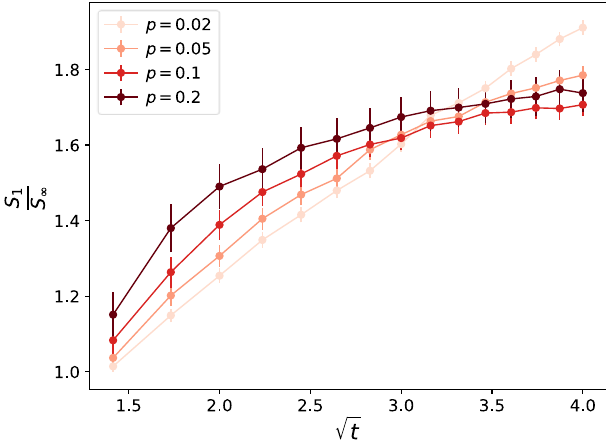
FIG. 10. Entanglement dynamics in the statistical mechanics ffiffi p S 1 =S ∞ Þ versus t model. Ratio R for L ¼ 12 . We find that s ¼ ð R saturates implying that S ∞ and S 1 are growing at the same rate s ∼ t . As expected, the saturation time is longer at low p . Error bars are from error in mean using standard deviations and standard error